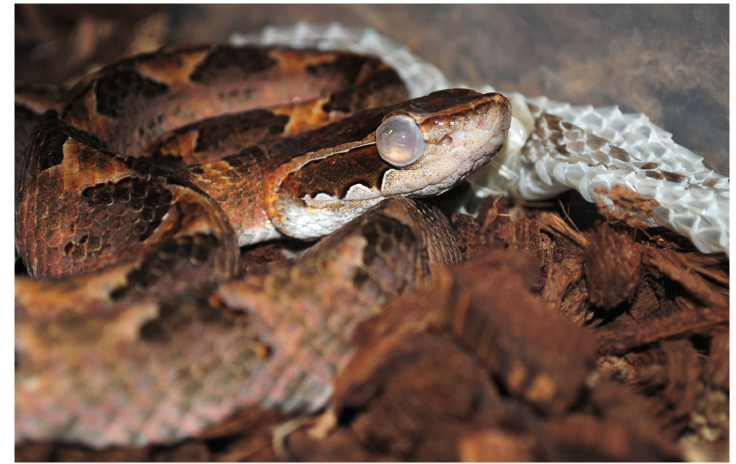
Figure 24. Idiopathic congenital pseudobupthalmos in a neonate Malayan pit viper ( Calloselasma rhodostoma ) shortly after the first shed after hatching. A morbidity of approximately 50% was wit- nessed within the clutch.